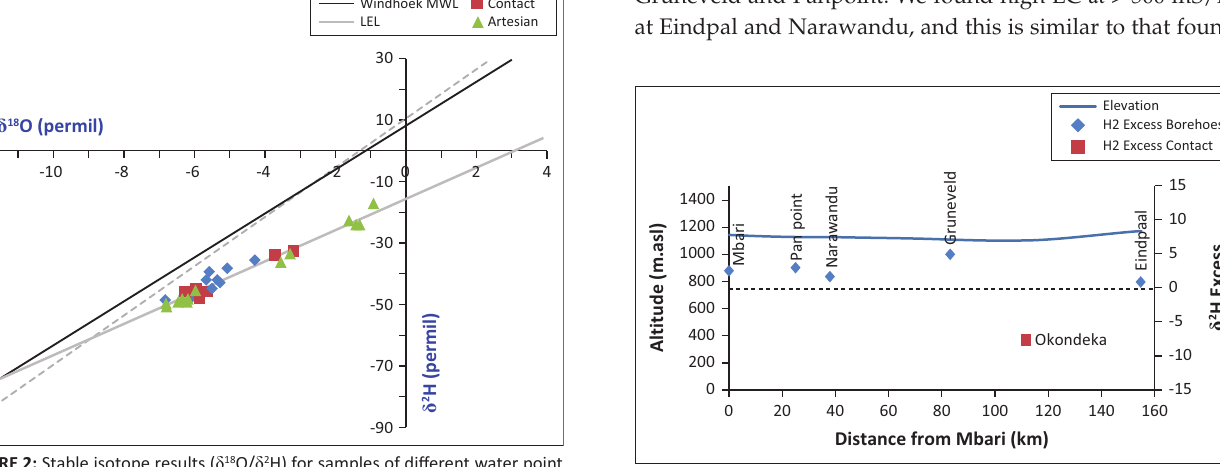
FIGURE 4: Variation of altitude, δ 2 H and δ 18 O (above) and δ 2 H excess (below), along an approximate north-south transect for different water point types in the Etosha National Park, May 2013, with altitude reference.